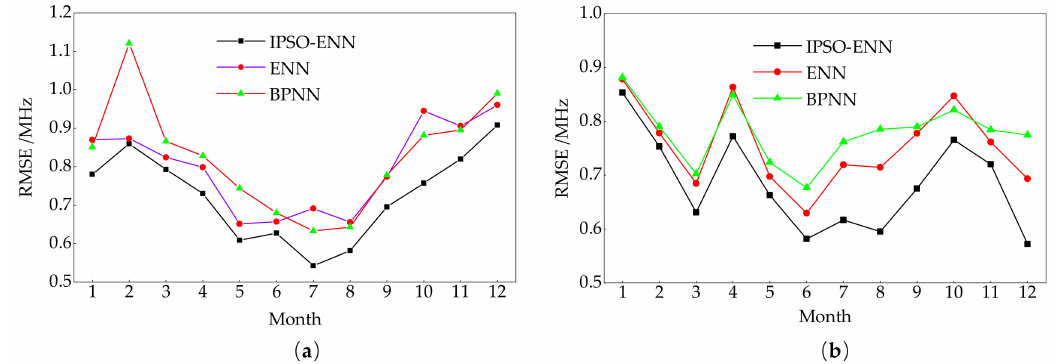
Figure 5. The monthly performance comparison. ( a ) RMSE of three models at each month in 2014; ( b ) RMSE of three models at each month in 2016.